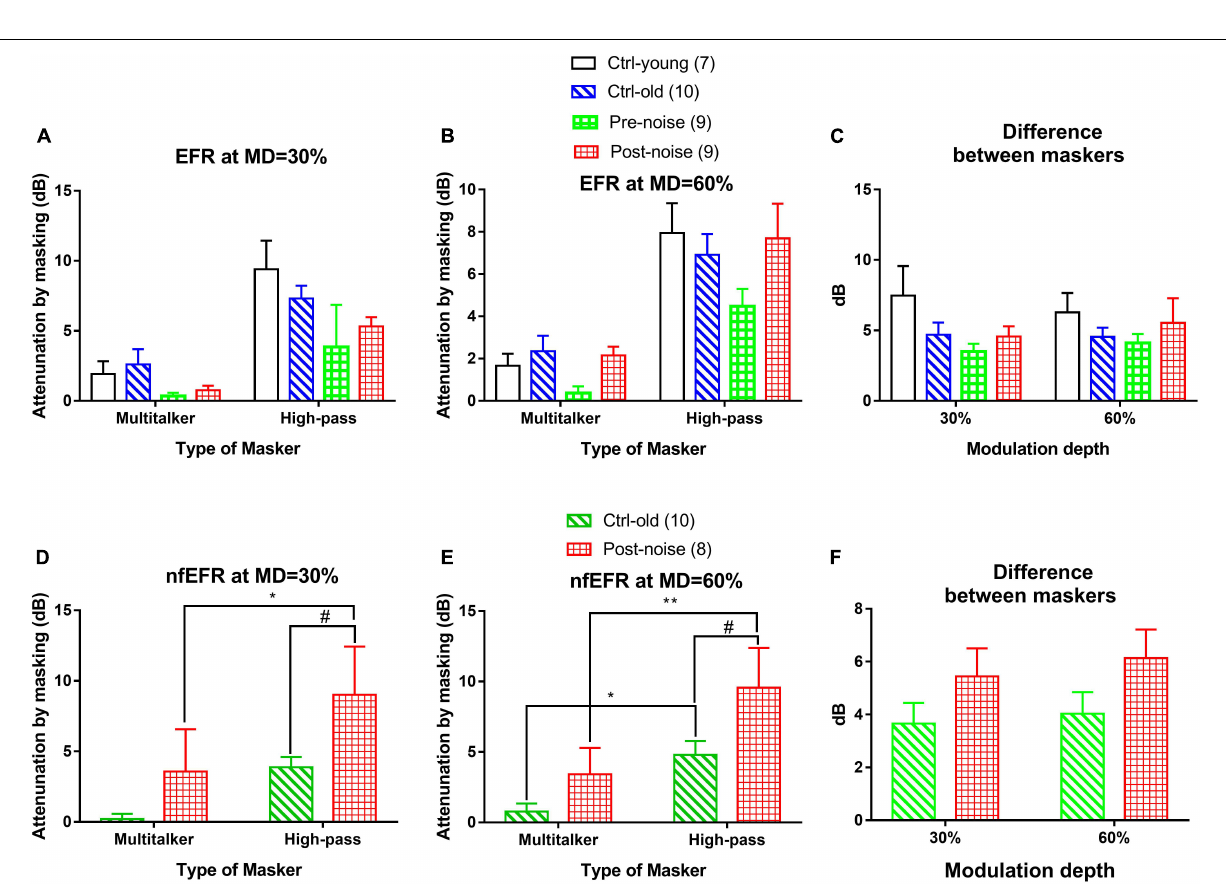
Frontiers in Neuroscience |